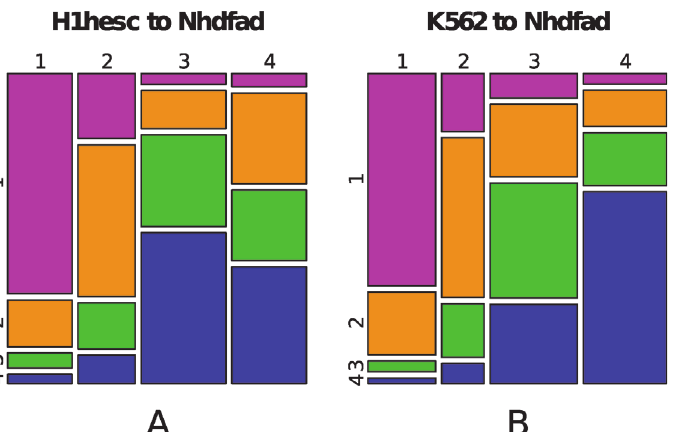
Figure 3. (A) Mosaic plot representing the probabilities of transition from H1hesc chromatin states to Nhdfad chromatin states. The width of columns corresponds to the proportion of chromatin states in H1hesc. The segmentation for the i th column follows the proportion of windows in state ECi in H1hec that become Cj in Nhdfad. In other words, if we take the first pink rectangle of the first column, its width is proportional to the probability for a 100 kb window to be in chromatin state EC1 in H1hesc and its height is proportional to the probability for a 100 kb window to be in C1 in Nhdfad given that it is in EC1 in H1hesc. The area of this rectangle (product of the previously mentioned probability) is proportional to the probability for a window to be in state EC1 in ESC and C1 in Nhdfad. (B) Same as (A) for the chromatin state changes from the cell line K562 towards Nhdfad.